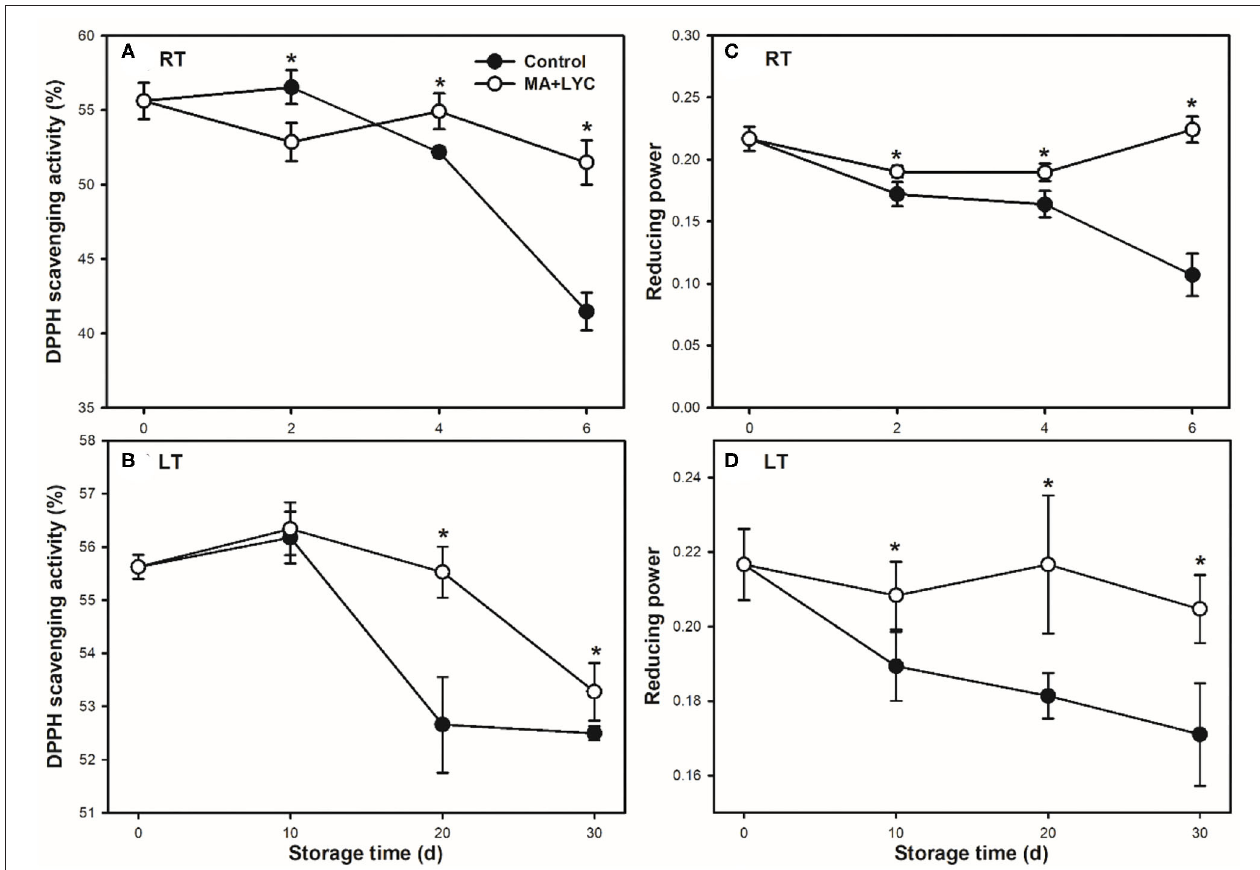
FIGURE 5 | Non-enzymatic antioxidant activities of DPPH radical scavenging capacity (A,B) and reducing power (C,D) in litchi stored at RT (25 ◦ C) and LT (4 ◦ C), respectively. Data are represented by mean values with the SD. Asterisk indicates the significant difference of means at 0.05 level.